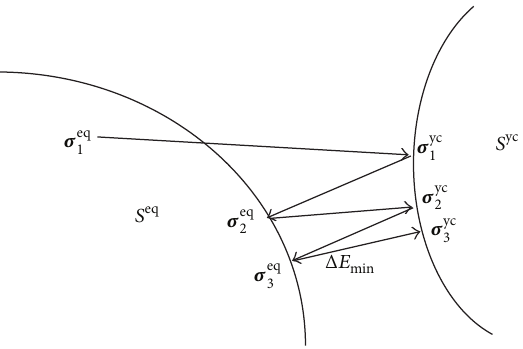
Figure 2: Demonstration of the elastoplastic iteration in FEM anal- ysis.